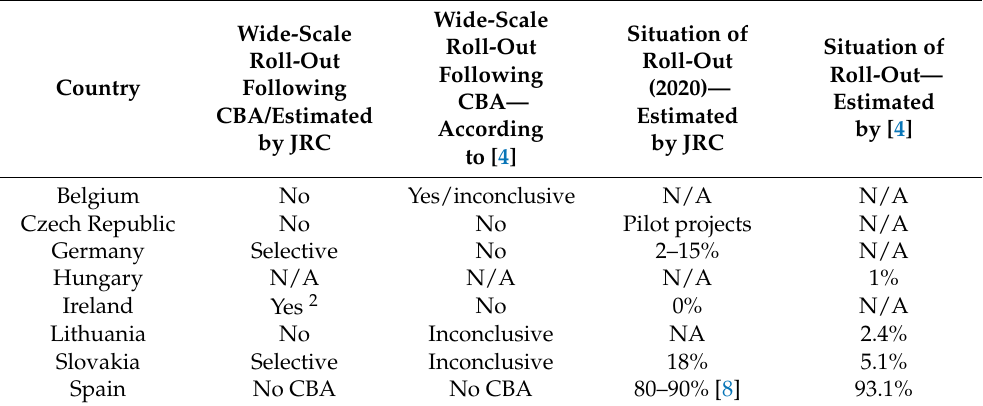
Table 2. Status of smart metering roll-out in countries that do not have an official positive outcome for their wide-scale roll-out, Source: [2] unless otherwise stated. Wide-Scale Situation of Wide-Scale Situation of Roll-Out Roll-Out Roll-Out Roll-Out— Following (2020)— Following Country Estimated CBA— Estimated CBA/Estimated by [4] According by JRC by JRC to [4] Belgium No Yes/inconclusive N/A N/A Czech Republic No No Pilot projects N/A Germany Selective No 2–15% N/A N/A N/A N/A 1% Yes 2 No N/A Inconclusive 2.4% Selective Inconclusive 18% 5.1% No CBA No CBA 80–90% [8]